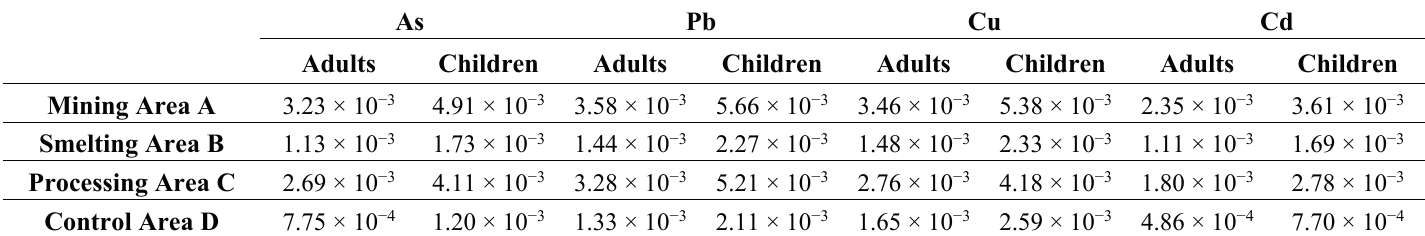
Table 7. Daily dietary intake of heavy metals; exposure per day/(mg/(kg·d)). As